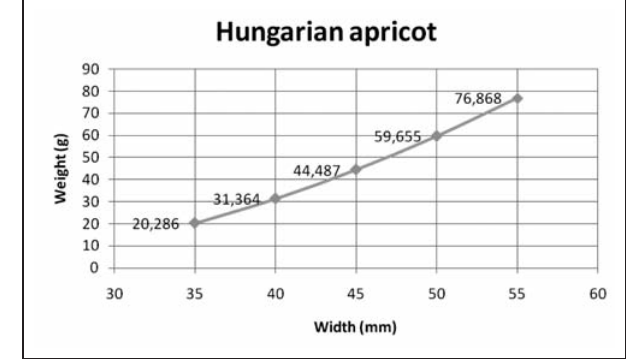
Fig. 14: Weight values calculated from the width-weight